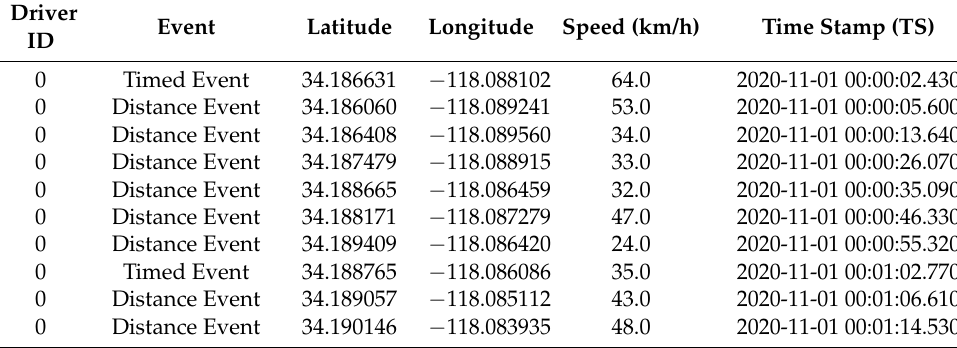
Table 4. Event based driver’s